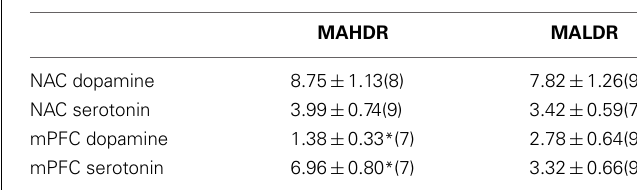
Table 3 | Basal extracellular levels of dopamine and serotonin (in fg/27 µ l sample) within the medial prefrontal cortex (mPFC) and the nucleus accumbens (NAC) of mice selectively bred for high vs. low methamphetamine drinking (MAHDR and MALDR, respectively), as determined using conventional microdialysis approaches.